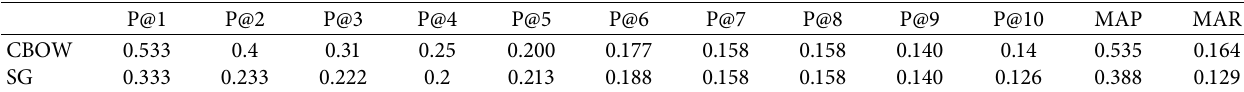
Table 9: The best-obtained results from the Gigaword corpus for p@(1–10), MAP, and MAR after fine tuning CBOW and SG training parameters which were obtained with window size � 2, dimensions � 150, and epochs � 50 (baseline results for the Gigaword corpus).